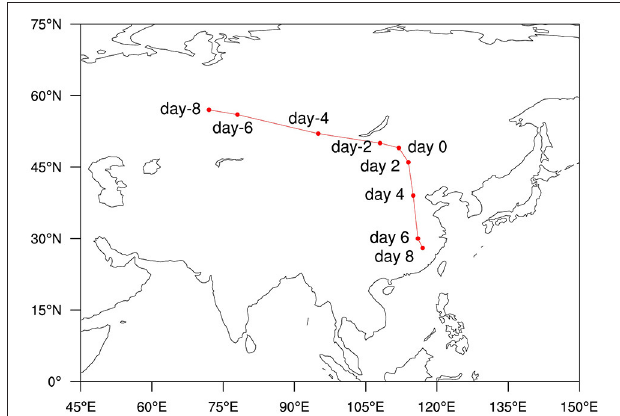
FIGURE 5 | Tracks of the composite 10–30-day filtered maximum temperature centers at 2m from day − 8 to day + 8, with an interval of 2 days. The red dots are same as the black dots shown in Figure 4 .